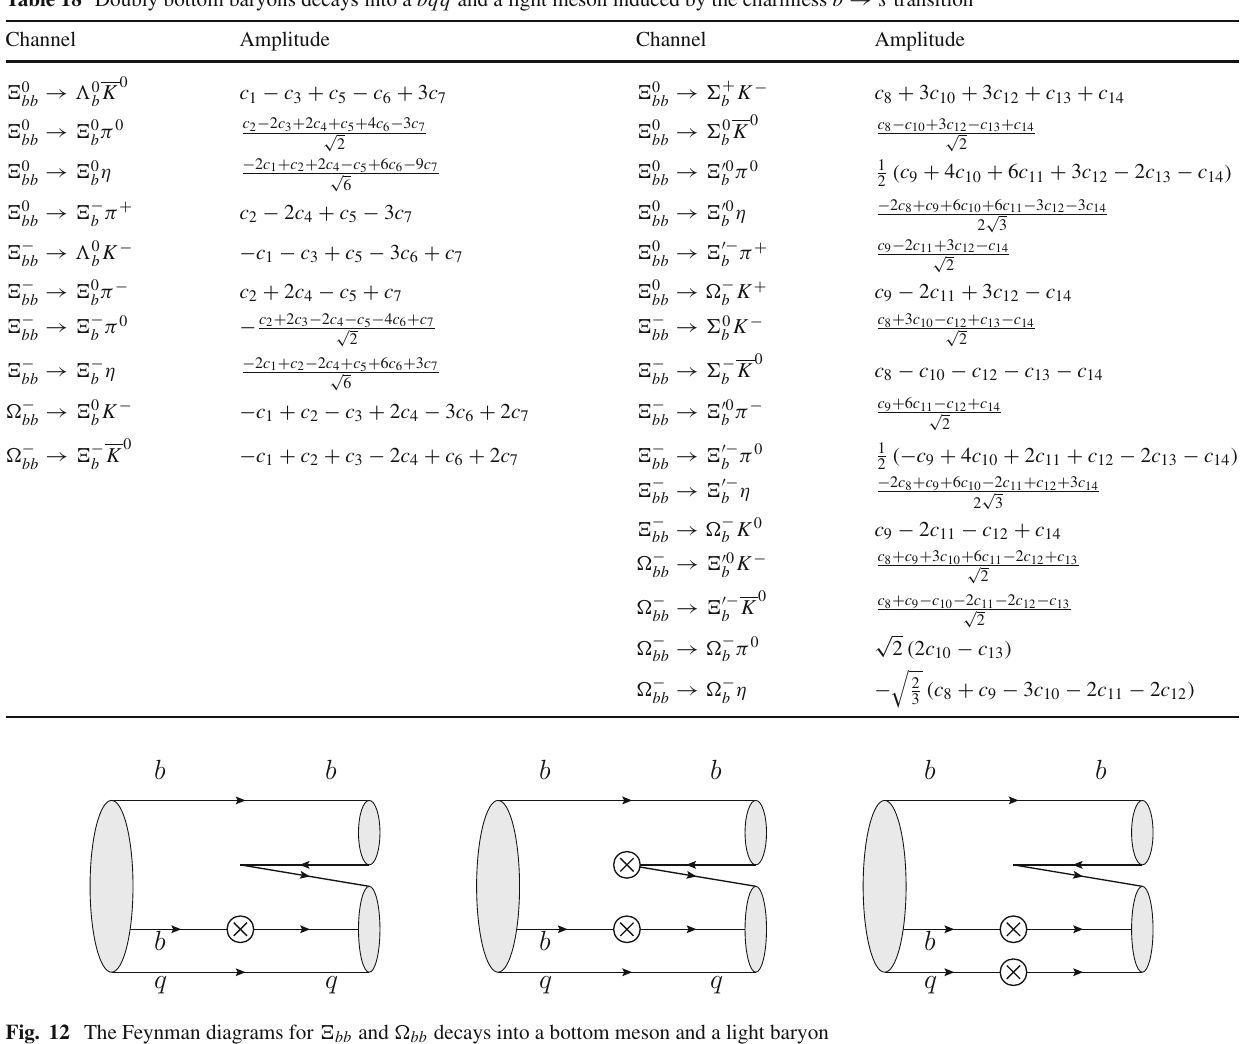
Fig. 12 The Feynman diagrams for (cid:2) bb and (cid:5) bb decays into a bottom meson and a light baryon + d ( T ) l B i (cid:14) ( T ) k ( H ) jn bb ijk 6 8 6 n